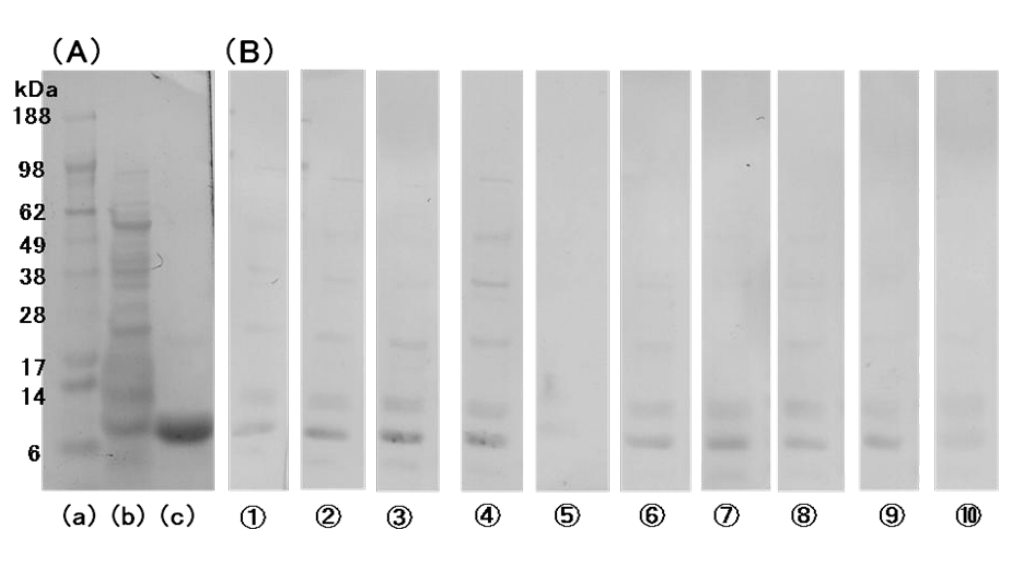
Figure 2. The reactivity of sera IgE obtained from food allergic patients with proteins in barley extract. ( A ) SDS-PAGE pattern of molecular mass markers (a), 8 µg of PBS- extracted barley proteins (b), and 2 µg of barley LTP (bLTP) (c). ( B ) Western blotting pattern of PBS-extracted barley proteins (8 µg) with sera from food allergic patients (No. 1–10). IgE was visualized with alkaline phosphatase-conjugated anti-human